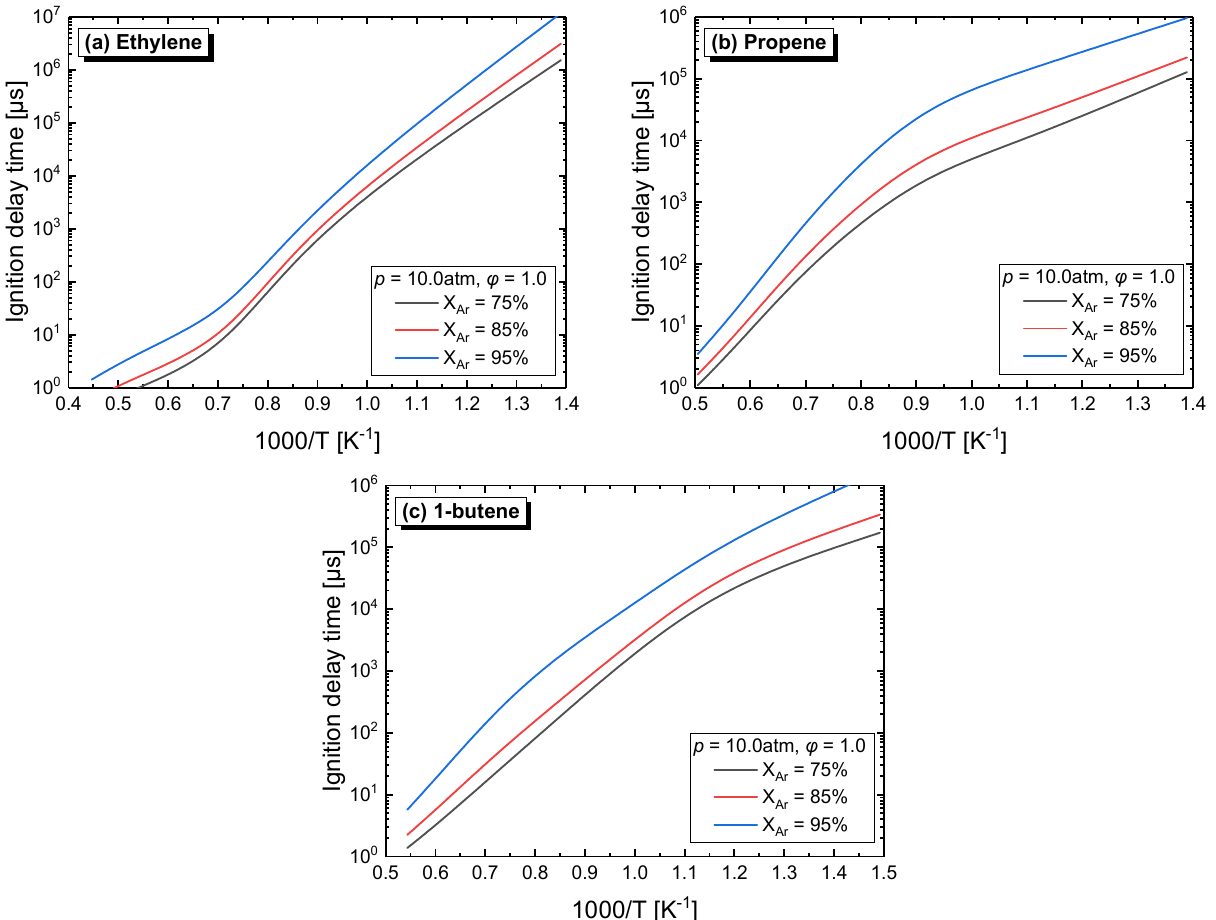
Figure 15. Constant volume adiabatic simulation of effect of dilution on IDTs for ethylene, propene and 1-butene using NUIGMech 1.1. ( a ) Ethylene; ( b ) propene; ( c ) 1-butene.